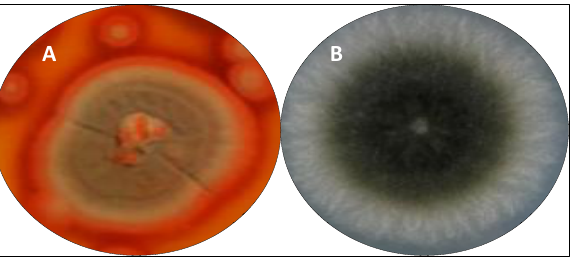
Figure 6. Illustration of the fungi species ( A ) P. maximae and ( B ) E. rostratum isolated by our group from the Brazilian biome, Caatinga.